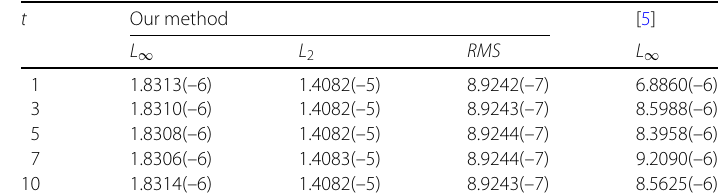
, k = 0.001, κ = 0.14, L = 10, n = 250, [ a , b ] = [30,80] 12